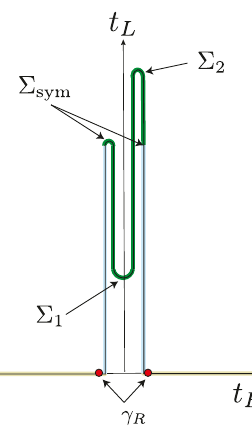
Figure 4 . The saddle can be extended in the real time direction by evolving using the data on Cauchy slice Σ sym . As an example, we depict the Schwinger-Keldysh contour for forward evolution up to surface Σ 2 and backward evolution up to surface Σ 1